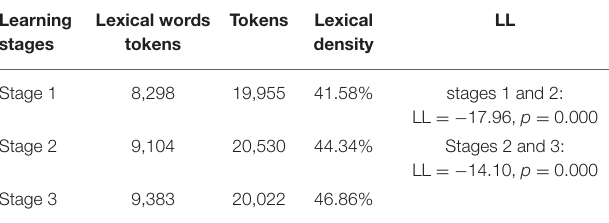
TABLE 5 | Lexical density per learning